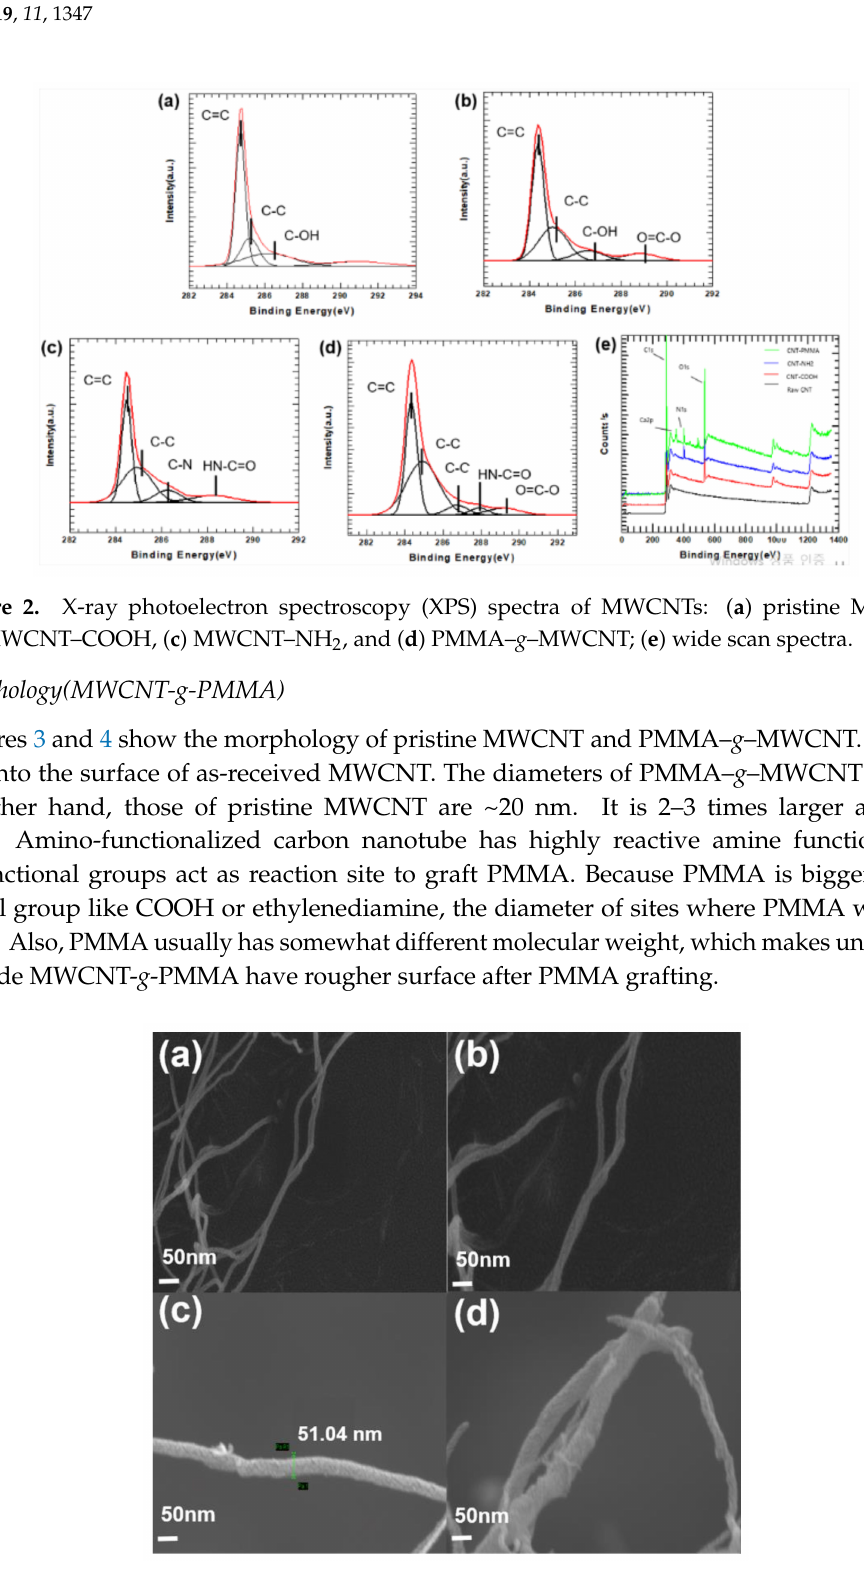
Figure 3. The SEM image of MWCNTs: ( a , b ) pristine MWCNT and ( c , d ) PMMA– g